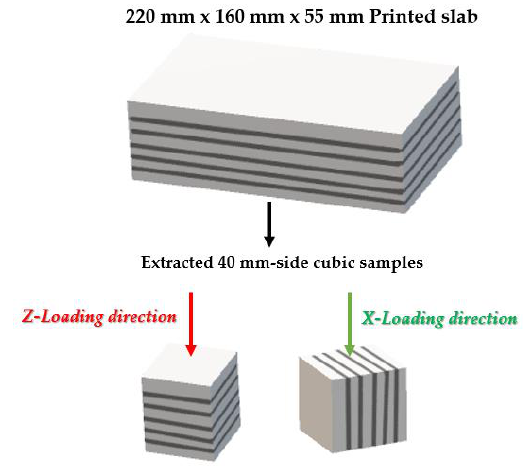
Figure 6. Testing direction for the compressive test.